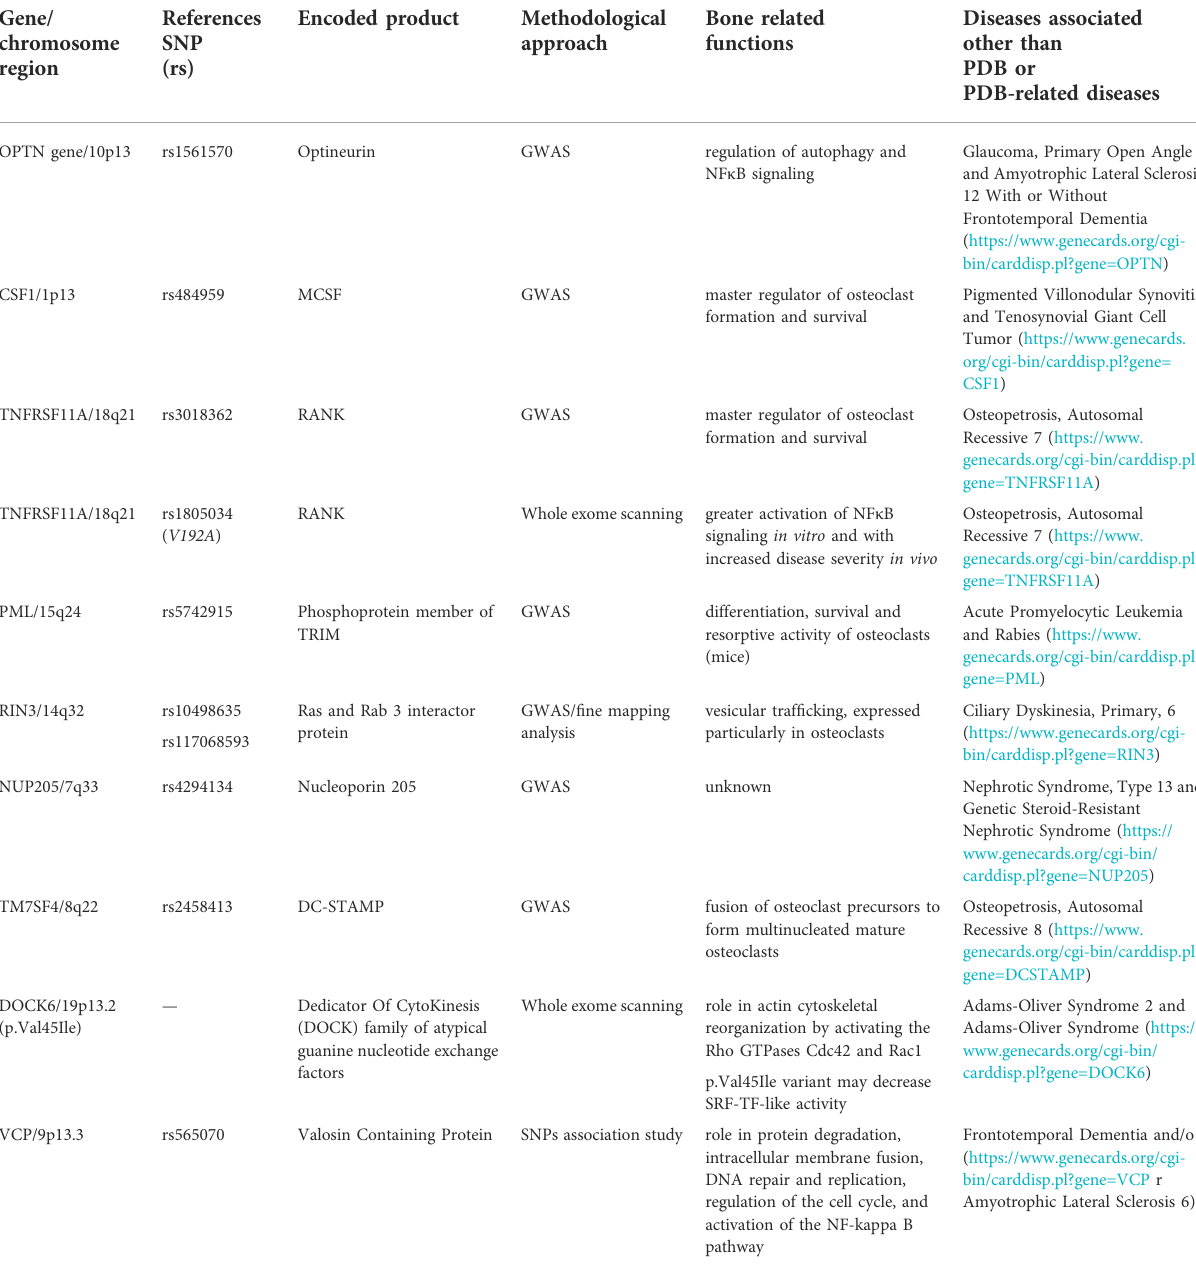
TABLE2PDB-predisposinggeneticvariants(withchromosomelocation),referenceSNPidenti fi cation,encodedproteins,bonerelatedfunctionsand associated diseases different than PDB and/or PDB-related